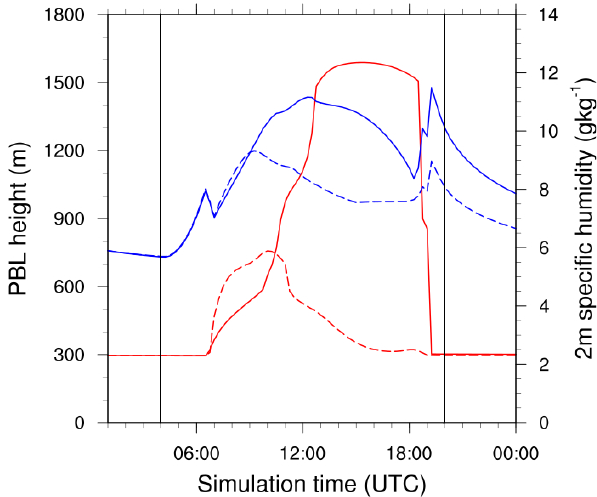
Fig. 13. 2m specific humidity (blue) and PBL height (red) for a sin- gle coast corkscrew simulation with 2ms − 1 along-shore gradient winds. Solid and dashed lines represent values at 150km onshore and at the coast, respectively. Sunrise and sunset are marked by the vertical black lines. The YSU PBL scheme was used in conjunction with a SST of 287K.